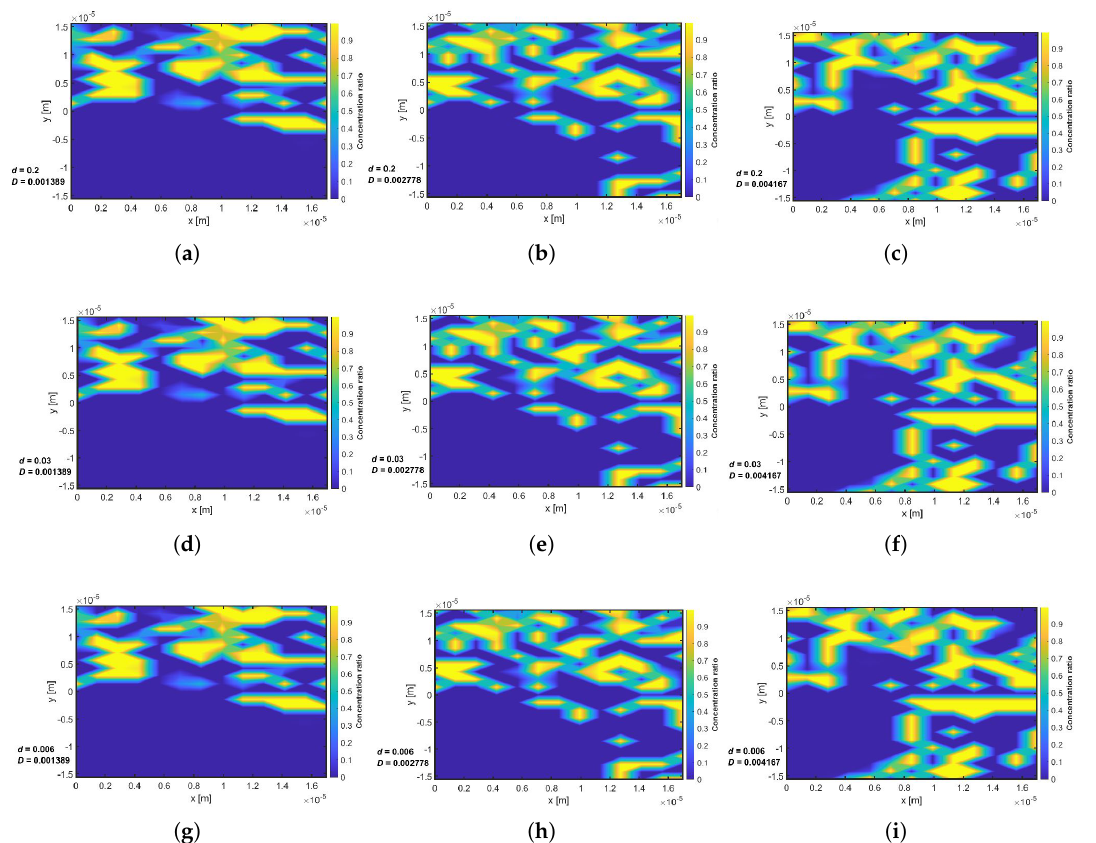
Figure 8. Contour plots of tracer concentration distribution within the porous media with linear drift ratio d = 0.006, 0.03 and 0.2 at 10